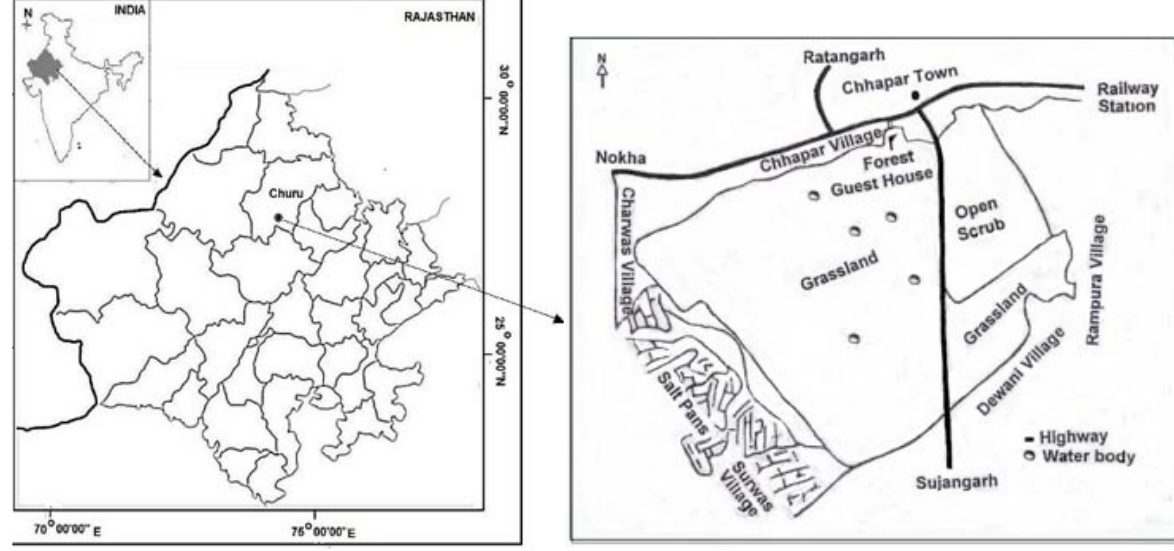
Figure 1. Map of Tal Chhapar Wildlife